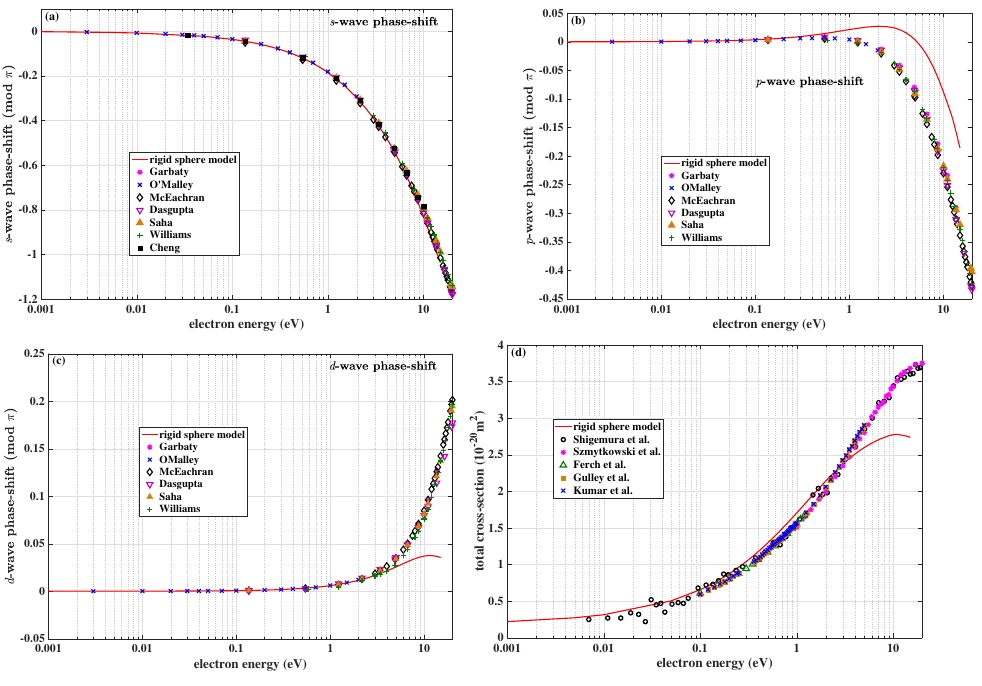
Figure 10. The rigid sphere model (solid lines) for low − energy e − − Ne scattering: ( a ) s − wave phase − shift, ( b ) p − wave phase − shift, ( c ) d − wave phase − shift and ( d ) integral elas- tic cross − sections. The model is compared with other works: phase − shifts by Garbaty and LaBahn [88], O’Malley and Crompton [89], McEachran and Stauffer [90], Dasgupta and Bha- tia [91], Saha [92], Williams [86], and Cheng et al. [18]; total cross − sections by Shigemura et al. [36], Szmytkowski et al. [35], Ferch et al. [93], Gulley et al. [51], and Kumar et al.